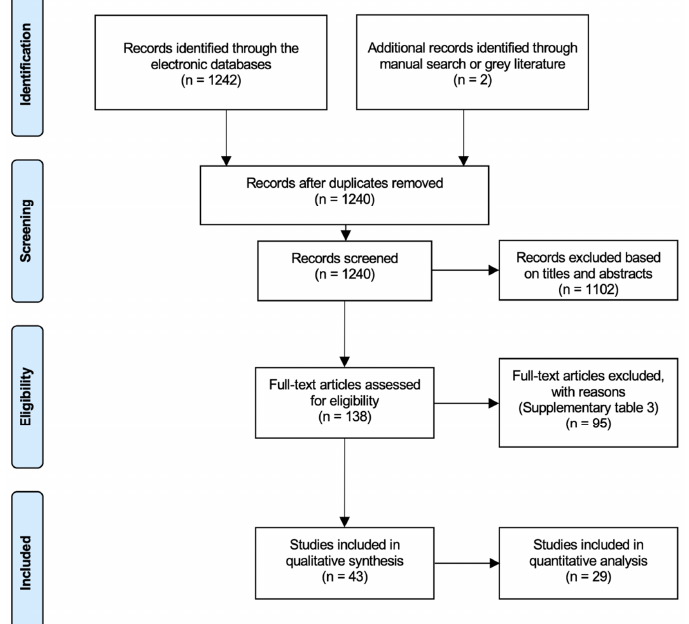
Figure 1. Preferred Reporting Items for Systematic Review and Meta-Analyses (PRISMA) flowchart of the screening process in the different databases.